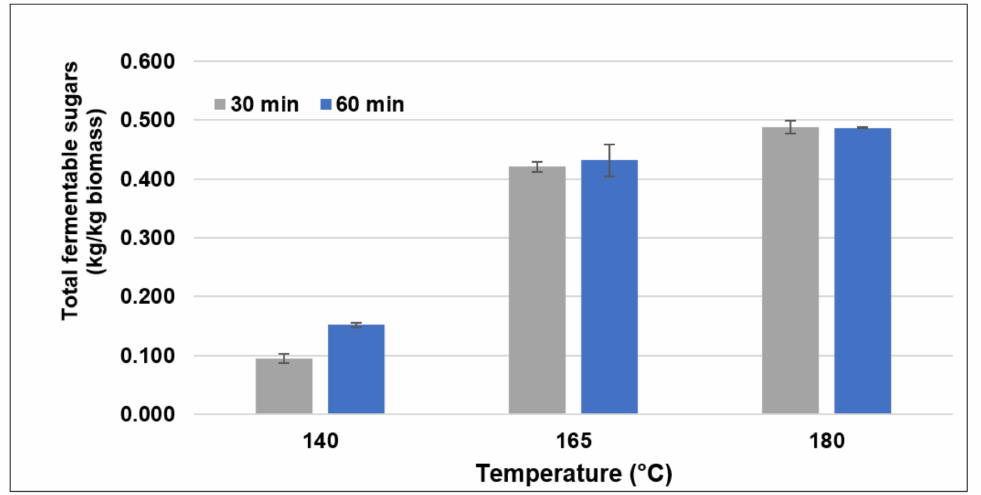
Figure 2. The total fermentable sugars from the enzymatic hydrolysis of different pretreatment